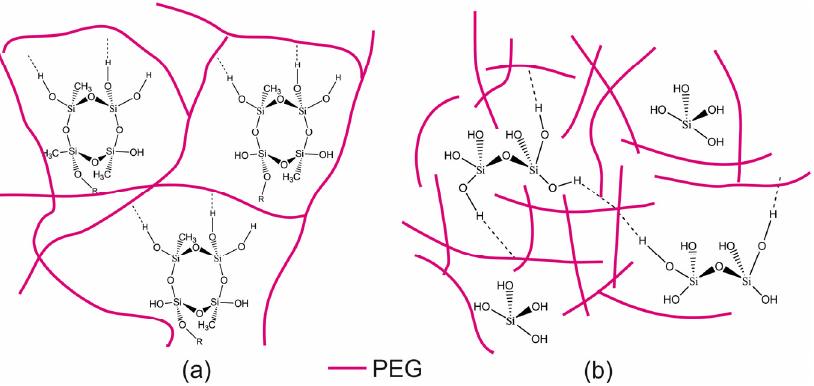
Figure 3. Assumed schematic structure of nanocomposites: ( a )SP EG -composite; ( b )STP EG